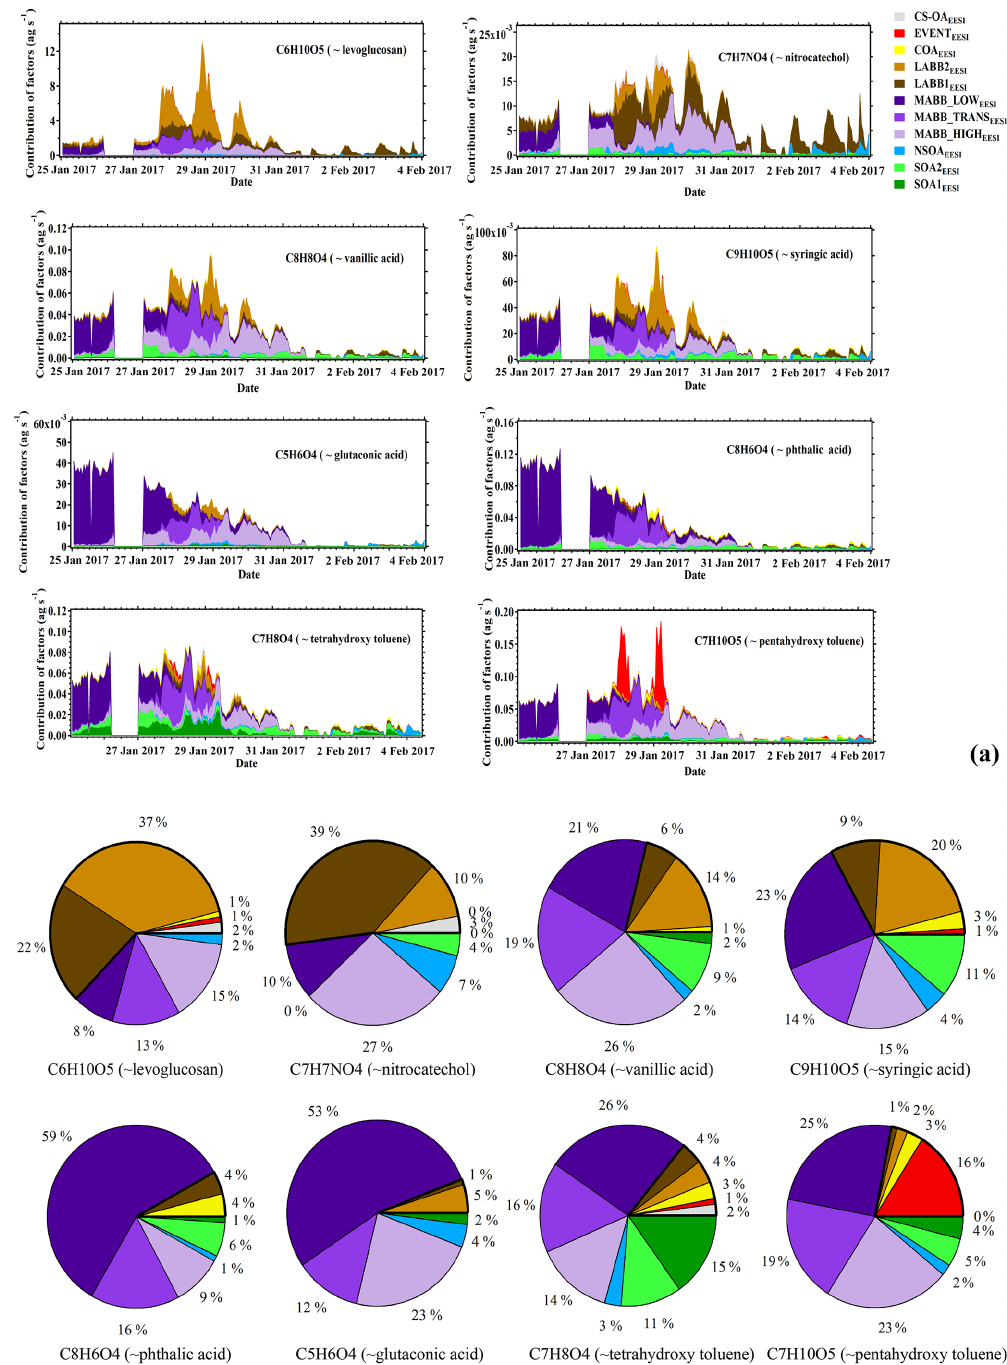
Figure 10. Apportionment of selected ions by EESI-TOF-MS PMF. (a) Time series of the mass flux (ags − 1 ) and (b) mean fraction ap- portioned to each factor. Each ion is associated with a compound of interest having this molecular formula; however, the relative isomeric abundance of this compound cannot be confirmed by the